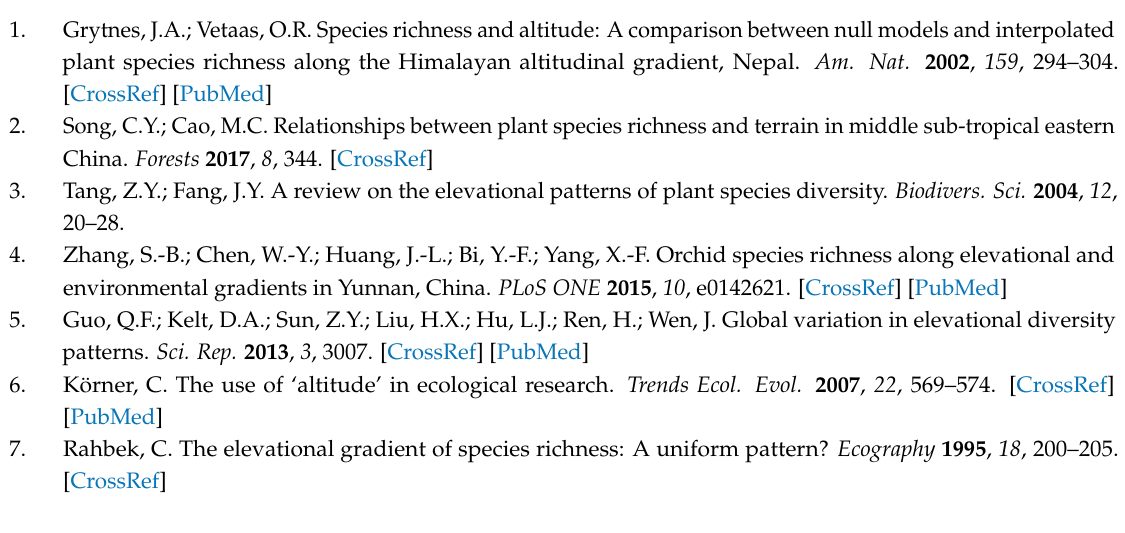
Figure S1: Land area associated with each elevational band, Figure S2: Variations in mean annual temperature and mean annual precipitation with elevation (A,C), and monthly temperature and precipitation at different elevations (B,D) based on the records of 119 meteorological stations between 1961 and 2004 in Yunnan. The value in parenthesis shows the elevations at each meteorological station, Figure S3: Mean elevation of trees and shrubs with Ericaceae in Yunnan. The elevational difference between trees and shrubs was tested by a Wilcoxon test, Table S1: Elevations, dominant species and canopy heights of main vegetations in Yunnan, Table S2: Number of species and life form in each genus of the family Ericaceae in Yunnan, Table S3: Bivariate relationships (r) among explanatory